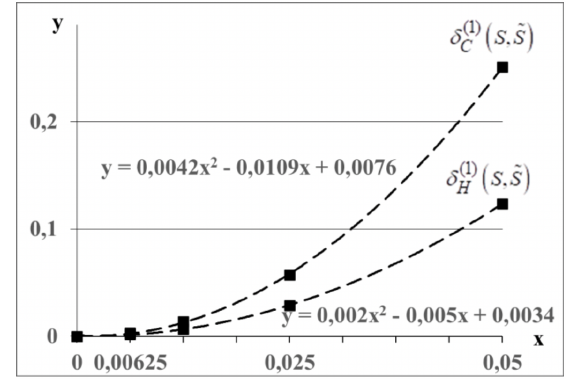
Fig. 1. (cid:4) - values of δ (1) regressions y ( x ) , x = h/a d .